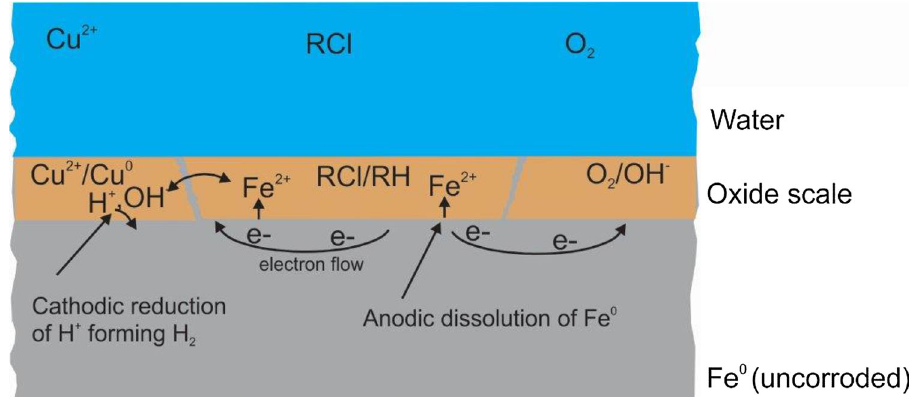
Fig. 1 The Fe 0 /H 2 O system labeling key features relevant for contaminant (e.g., Cu 2 + , O 2 and RCl) removal. Corrosion begins at a location where Fe 2 + is generated (anode). Fe 2 + goes into the aqueous solution and two electrons, left behind migrate to another location (cathode) where they are taken up by H + from water dissociation. The resulting hydroxide ions (OH − ) react with the Fe 2 + to initially form